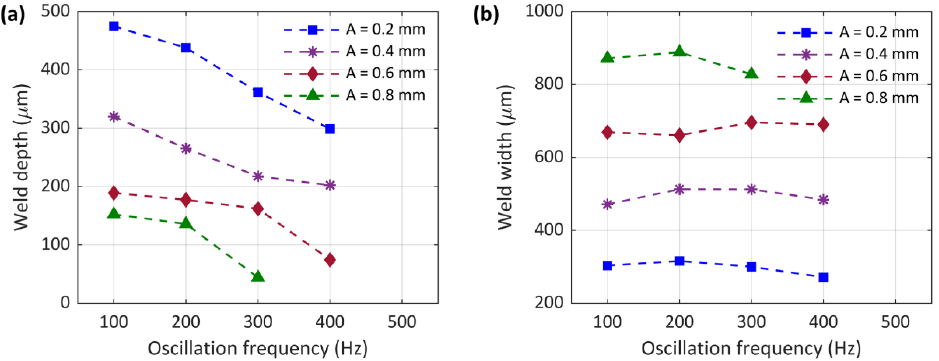
Figure 10. ( a ) Weld depth and ( b ) weld width versus oscillating amplitudes (0.2 mm, 0.4 mm, 0.6 mm, and 0.8 mm) and oscillation frequencies (100 Hz, 200 Hz, 300 Hz, and 400